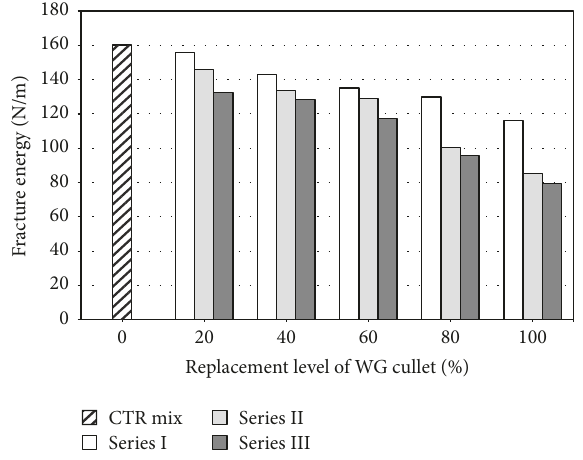
Figure 10: Fracture energy of SCC mixtures at 28 days with respect to WG cullet